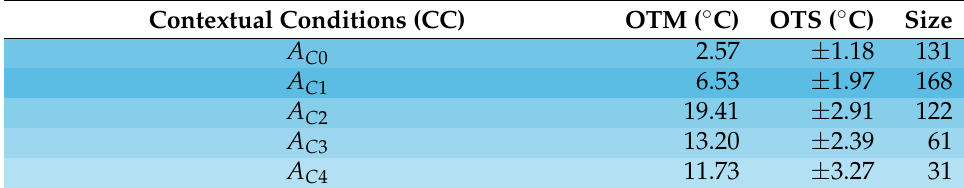
Table 5. Contextual conditions identified after receiving chunk